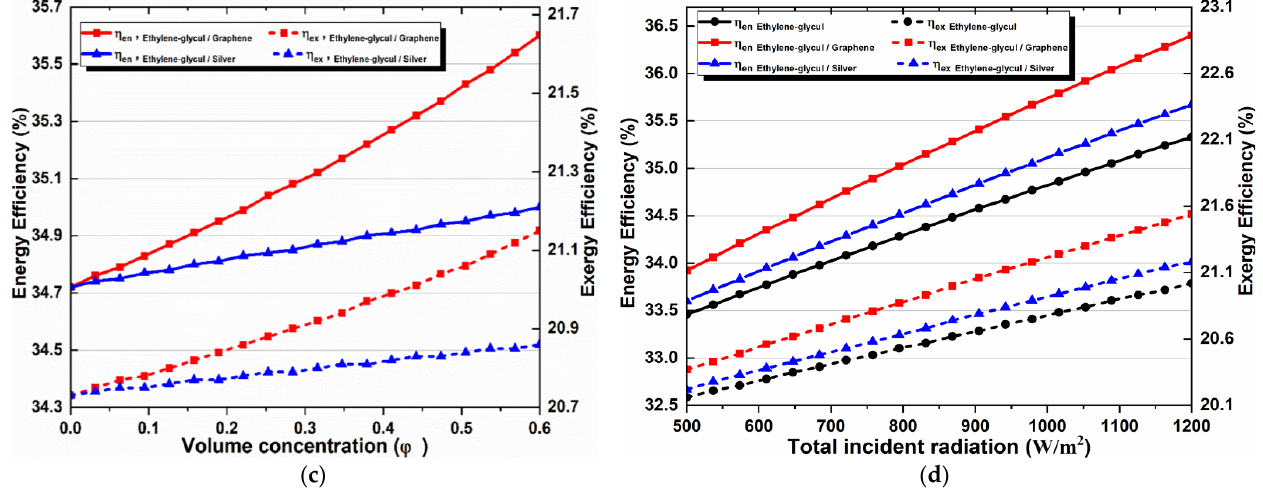
Figure 7. Effects of ( a ) nanoparticle volume concentration on the net electricity production, ( b ) nanoparticle volume concentration on heating and cooling loads, ( c ) nanoparticle concentration on overall energy and exergy efficiencies, and ( d ) solar irradiation on overall energy and exergy efficiencies.